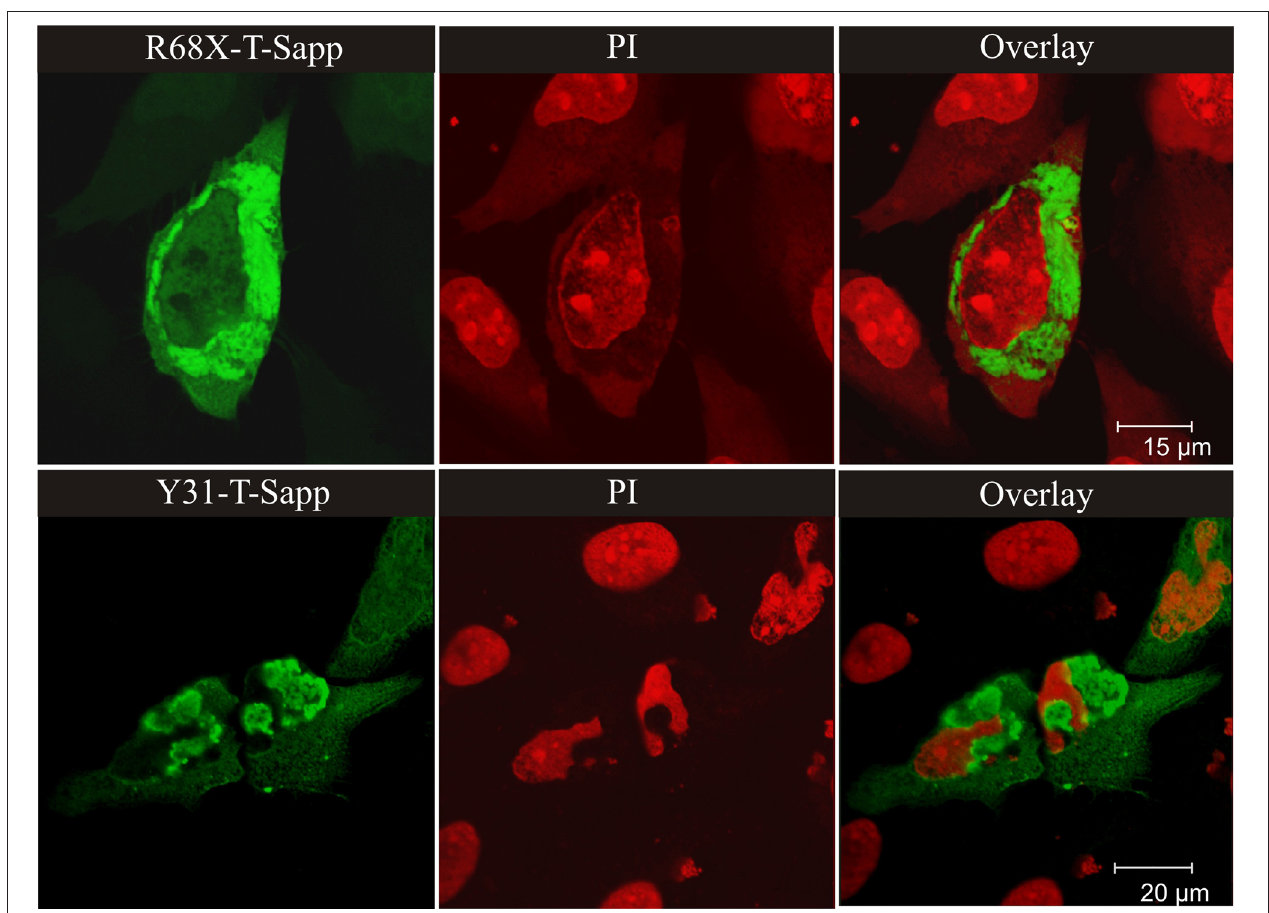
FIGURE 1 | Perinuclear aggregates of the EPM1 R68X mutant and of the most aggregate prone wild-type variant stefin B with Y31 (both fused with green fluorescent protein T-Sapphire). The nuclei were labeled with